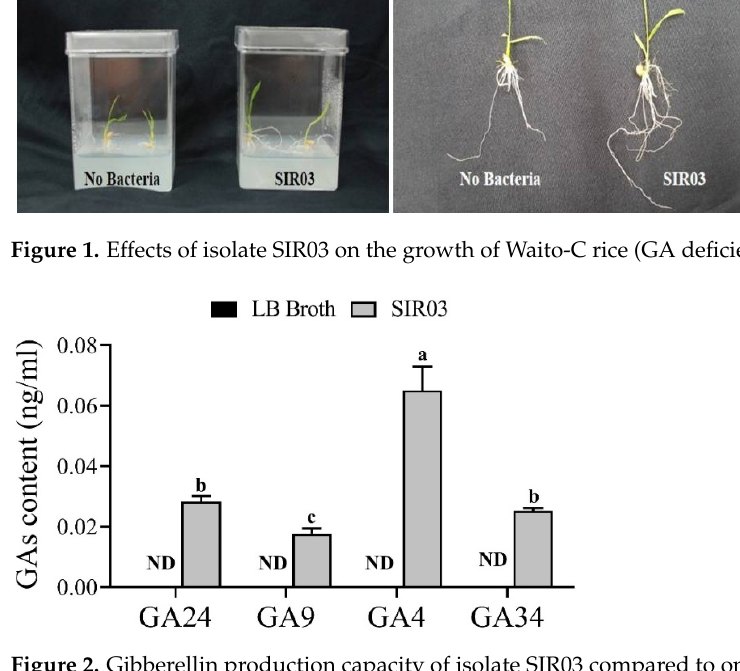
Figure 2. Gibberellin production capacity of isolate SIR03 compared to only LB broth (without any bacteria). The values are means ± standard deviations of three replicates. Results indexed with different letters represent significant differences between different GAs, while ND represents not detected, evaluated by Duncan’s multiple range test at p ˂ 0.05.